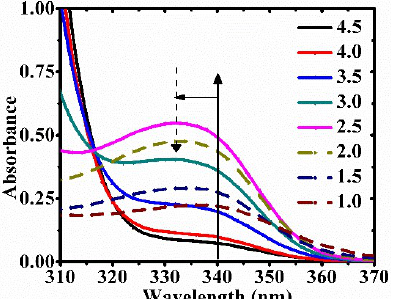
Figure 2. Degradation of NADH at pH 1.0 to 4.5. General conditions: NADH (1.4 mg, 2 μmol); phosphate buffer (2 mL); 3 h; 37 ◦ phosphate buffer (2 mL); 3 h; 37 °C.